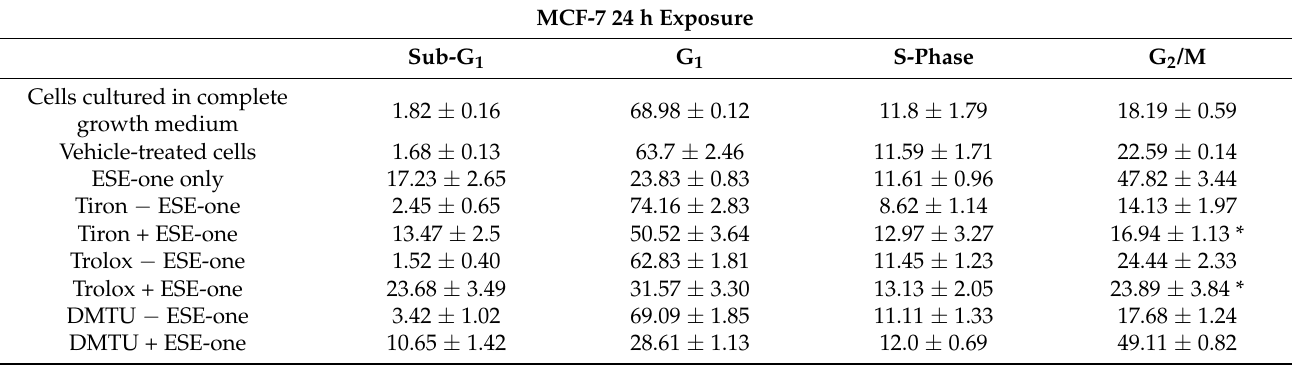
Figure 2. Cell cycle progression graphs of MCF-7 and MDA-MB-231 cells exposed to ESE-one in the presence or absence of several scavengers of reactive oxygen species (tiron, trolox and DMTU) for 24 h. ESE-one exposure resulted in a G 2 /M block in both MCF-7 and MDA-MB-231 cells. Tiron and DMTU exposure significantly decreased the number of cells blocked in sub-G 1 phase in MDA-MB-231 cells and tiron as well as trolox exposure significantly decreased the number of cells blocked in G 2 /M phase in both MCF-7 and MDA-MB-231 cells. ( a ) MCF-7 cells cultured in complete growth medium, ( b ) vehicle-treated MCF-7 cells, ( c ) MCF-7 cells exposed to ESE-one only, ( d ) MDA-MB-231 cells cultured in complete growth medium, ( e ) vehicle-treated MDA-MB-231 cells, ( f ) MDA-MB-231 cells exposed to ESE-one, ( g ) MCF-7 cells exposed to tiron only, ( h ) MCF-7 cells exposed to trolox only, ( i ) MCF-7 cells exposed to DMTU only, ( j ) MCF-7 cells coexposed to tiron and ESE-one, ( k ) MCF-7 cells coexposed to trolox and ESE-one, ( l ) MCF-7 cells coexposed to DMTU and ESE-one, ( m ) MDA-MB-231 cells coexposed to tiron only, ( n ) MDA-MB-231 cells exposed to trolox only, ( o ) MDA-MB-231 cells exposed to DMTU only, ( p ) MDA-MB-231 cells coexposed to tiron and ESE-one, ( q ) MDA-MB-231 cells coexposed to trolox and ESE-one, ( r ) MDA-MB-231 cells coexposed to DMTU and ESE-one. Table 1. Percentage of MCF-7 cells occupying each cell cycle phase as determined by means of flow cytometry using propidium iodide after 24 h exposure. An asterisk (*) indicates p -value ( p < 0.05) compared to ESE-one treated